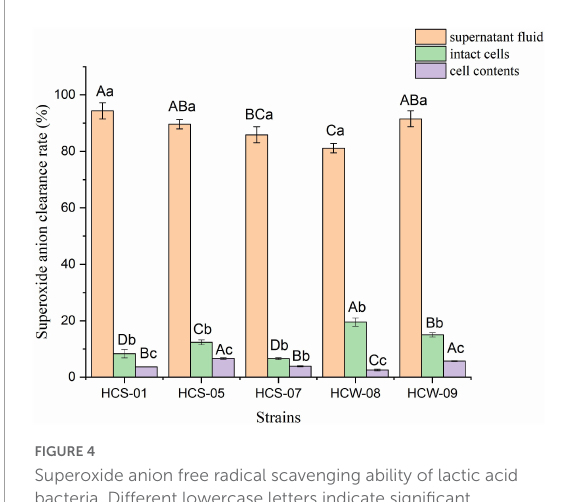
FIGURE4 Superoxide anion free radical scavenging ability of lactic acid bacteria. Different lowercase letters indicate significant differences among different components of the same strain ( P < 0.05); different capital letters indicate significant differences among the same components of different strains ( P <